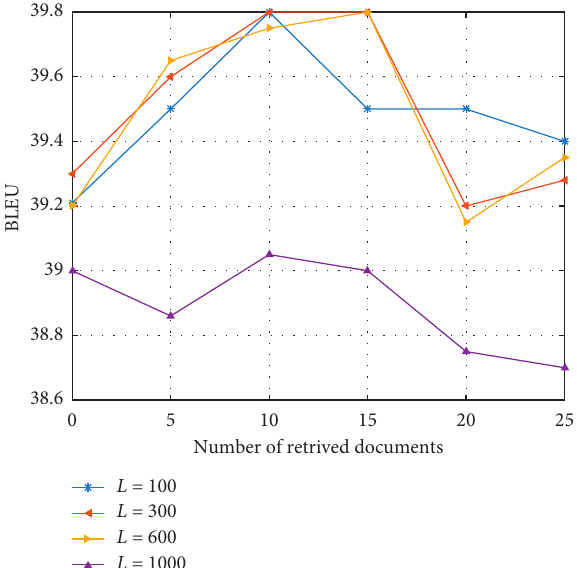
Figure 8: The impact of different features on the translation